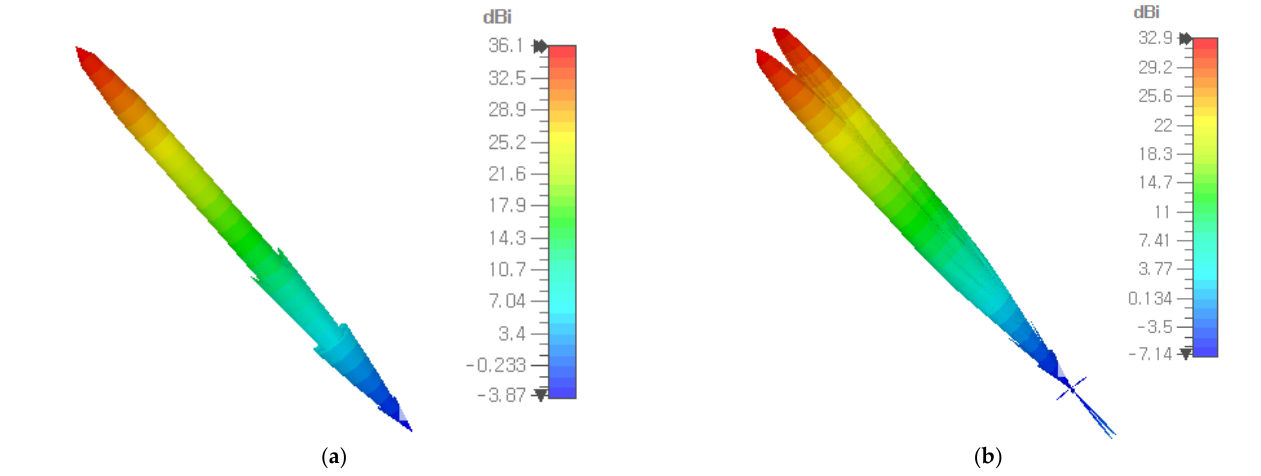
Figure 21. 3D directivity patterns of the reflector at 14.5 GHz. ( a ) Sum pattern. ( b ) Azimuth difference pattern. Arrows mark the maximum and minimum values of the directivity. Table 4. Performance of the proposed monopulse antenna at 14.5–16.0 GHz.